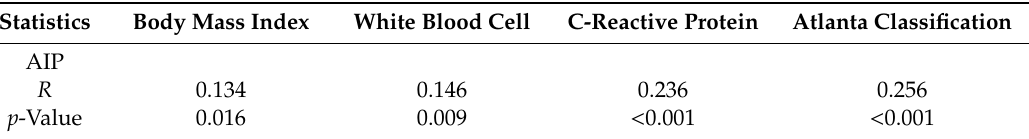
Figure 2. Receiver operator characteristic curve of various factors as predictors of severe acute pancreatitis. AIP: atherogenic index of plasma; CTSI: computed tomography scoring index; BISAP: the Bedside Index for Severity in Acute Pancreatitis. Table 3. The correlation of the AIP and other variables.